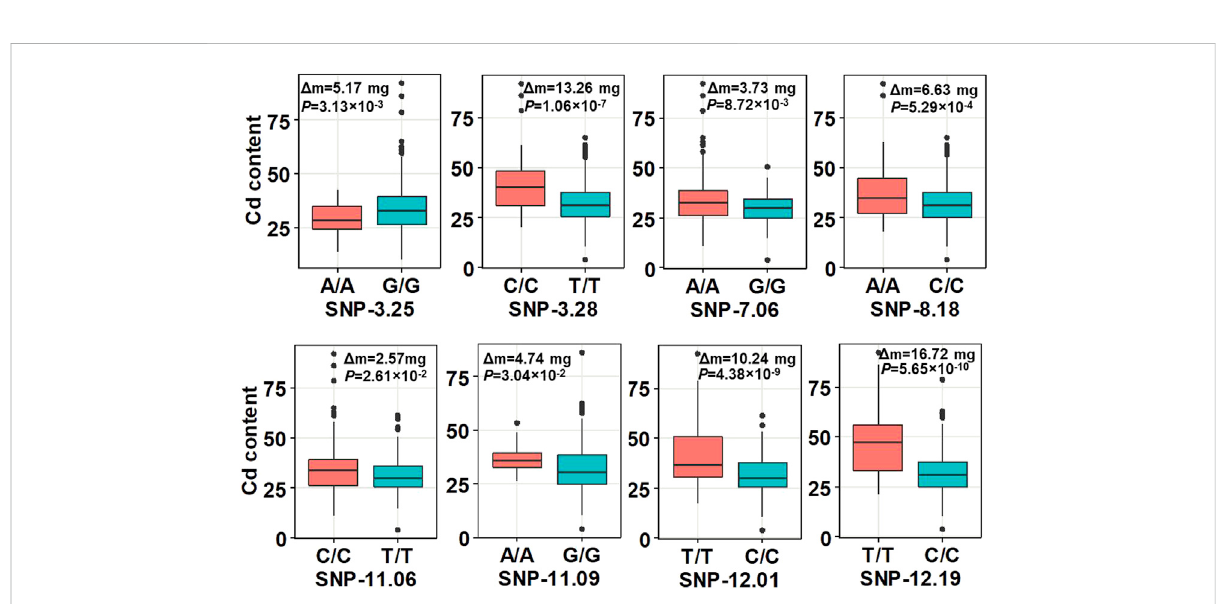
FIGURE 2 Boxplot of the phenotype analysis between the peak SNPs in the QTLs and phenotypic difference between minor alleles and major alleles. Δ m, the difference of the mean of shoots ’ Cd concentration between the minor alleles and major alleles at the seedling stage with three replications. Statistical comparison was performed by a one-sided t